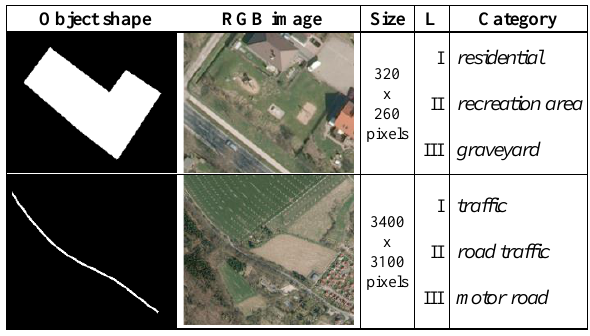
Figure 1: Two database objects with images (rescaled) and categories in three semantic layers. L: semantic layer starting from the coarsest ( I ) to the finest ( III